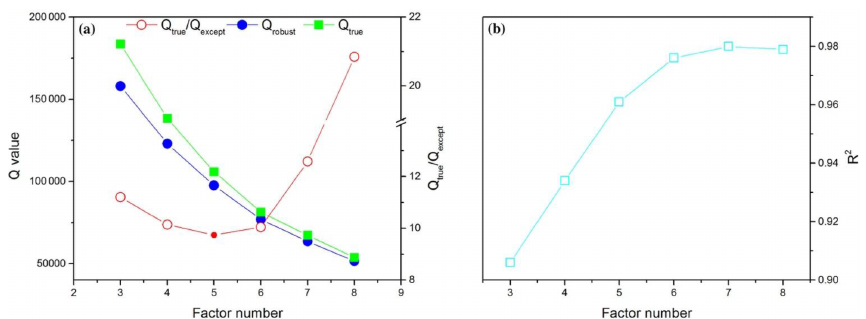
Figure A2. Q true /Q except , Q robust and Q true plotted against the number of factors used in the positive matrix factorization (PMF) solution (a) and the correlation coefficients ( r 2 ) between observed and predicted VOC concentrations of each factor solution (b) .